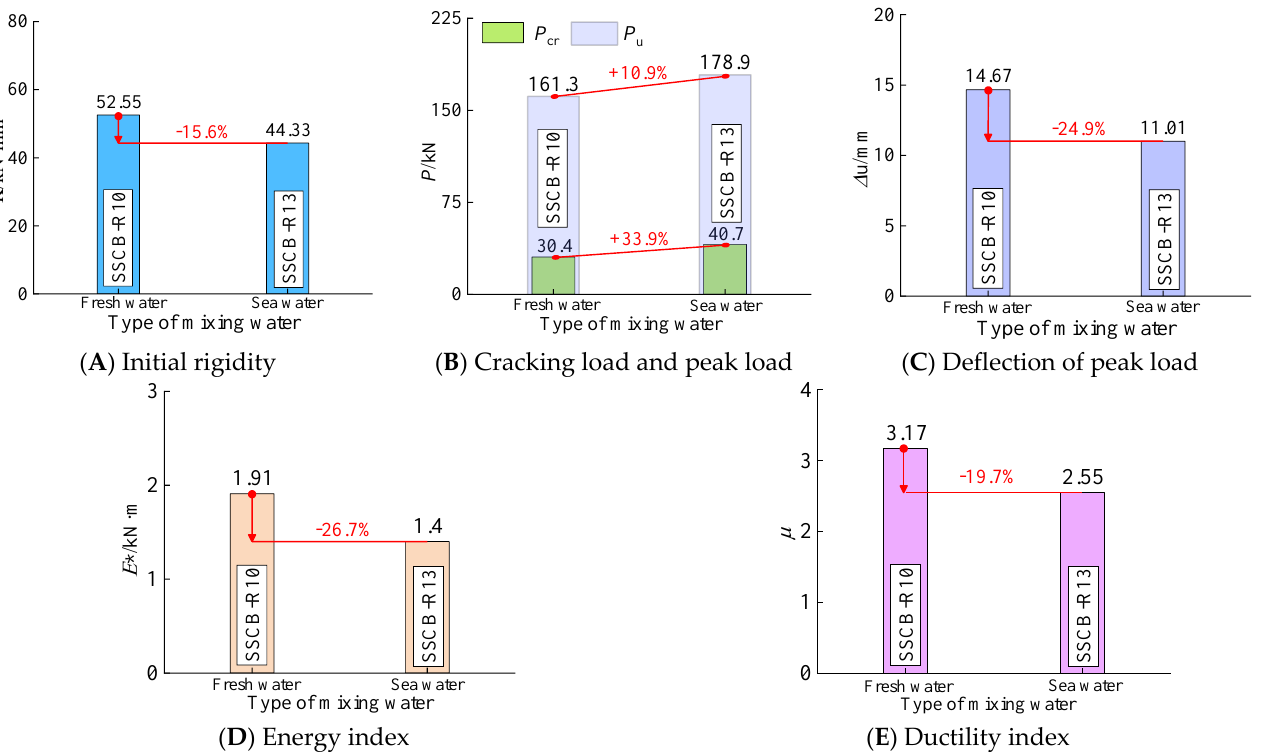
Figure 8. The performance index varies with the type of mixing water.